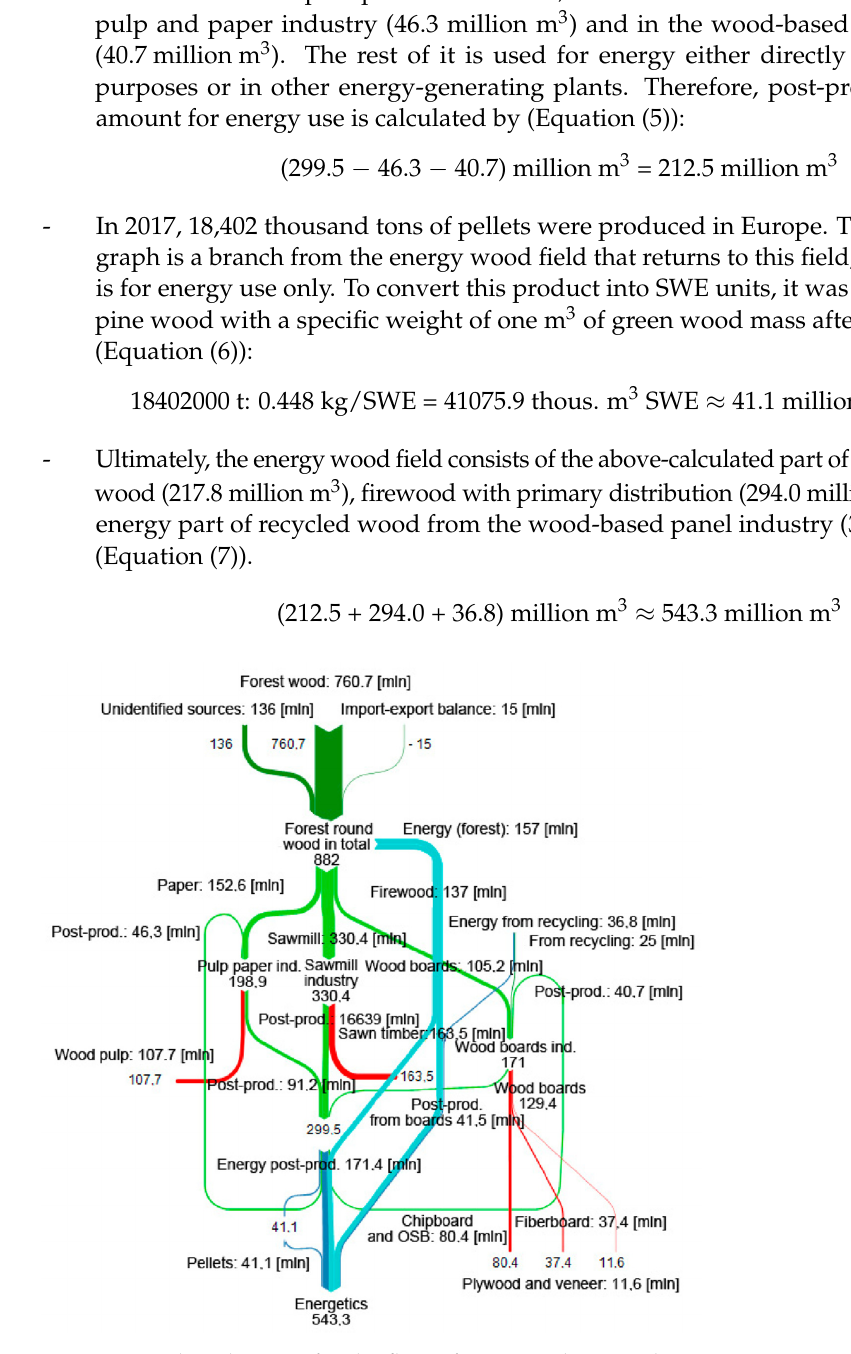
Figure 2. Sankey diagram for the flow of raw wood material in Europe in 2017 (unit: millions of m 3 of solid wood equivalent (SWE)). Source: own based on FAO Forest Products 2017 statistics and own calculations. Table 2. Raw wood material distribution in Europe in 2017.